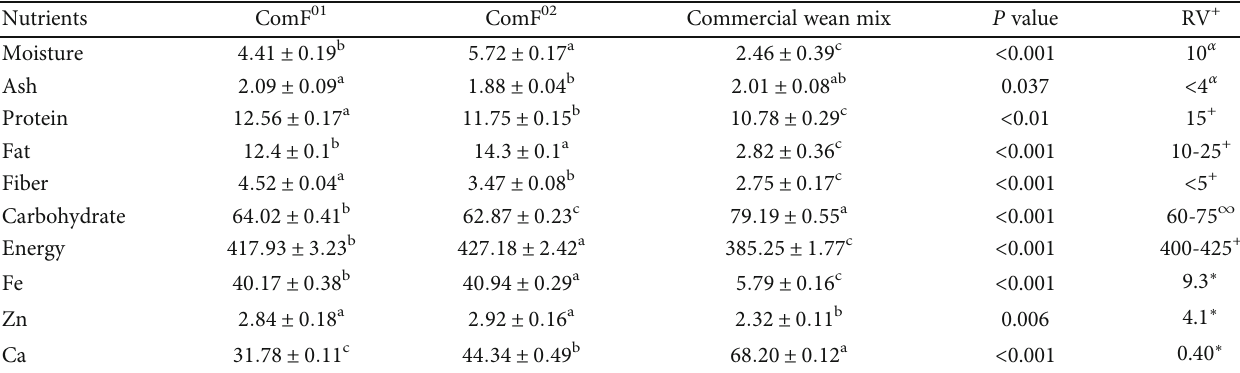
Table 2: Proximate (g/100 g), energy content (kcal/100 g), and mineral (mg/100 g) composition of extruded complementary foods and commercial wean mix.